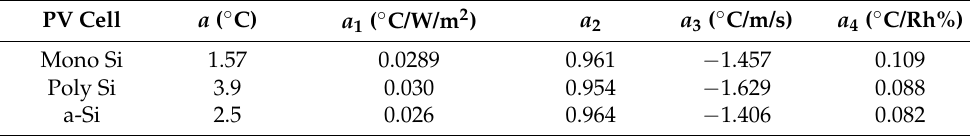
Table 3. PV technology and corresponding PVct model regression